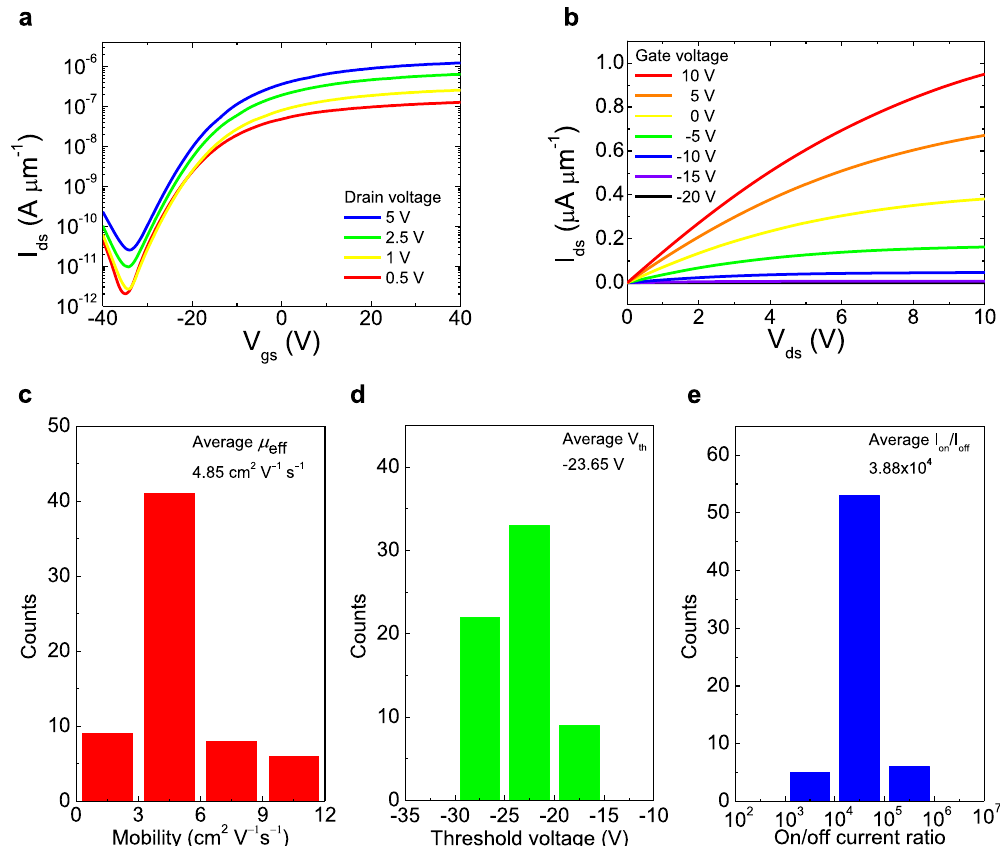
Fig. 4 Electrical characteristics and statistical analysis of phototransistors in bilayer MoS 2 image sensor array. a V gs – I ds curves of MoS 2 phototransistor at V ds = 0.5, 1, 2.5, and 5 V. b V ds – I ds curves of MoS 2 phototransistor at V gs from − 20 to 10 V with the gap of 5 V. Histograms of c fi eld-effect mobility (average μ eff = 4.85 cm 2 V − 1 s − 1 ), d threshold voltage (average V th = − 23.65 V), and e on/off current ratio (average I on / I off = 3.88 × 10 4 ) of the 64 MoS 2